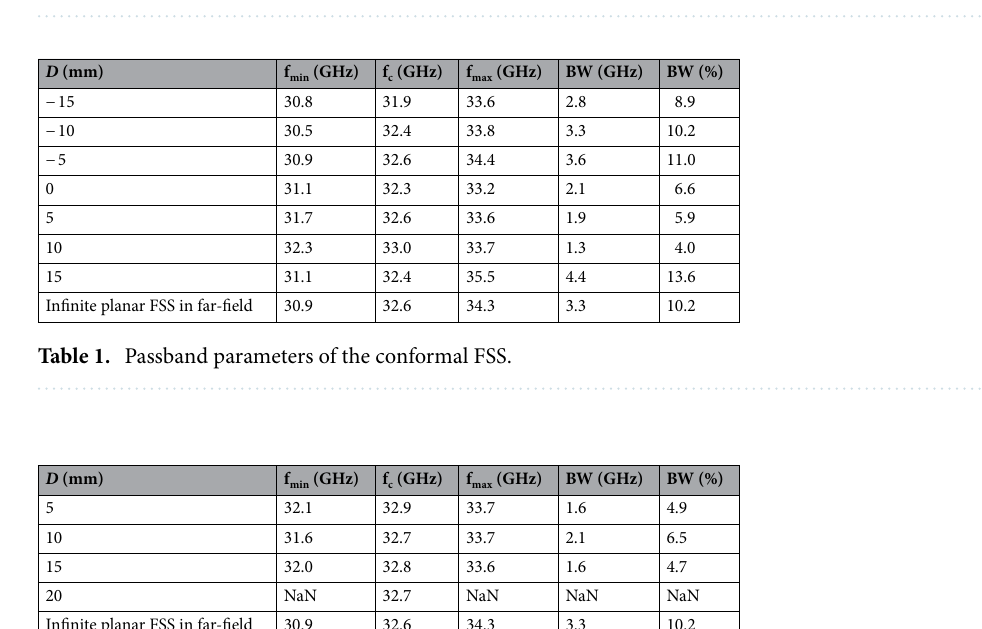
Figure. 11. Rejection properties of the conformal FSS, measured by rotating it in the XY plane.